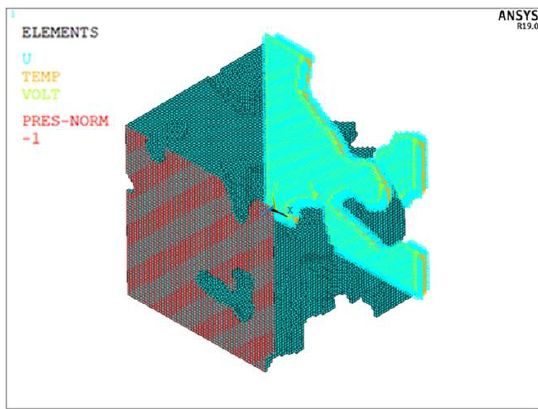
Figure 10. Simulation loading diagram. Green represents a fixed constraint, and red represents applied tensile stress. The element type is Solid 226.